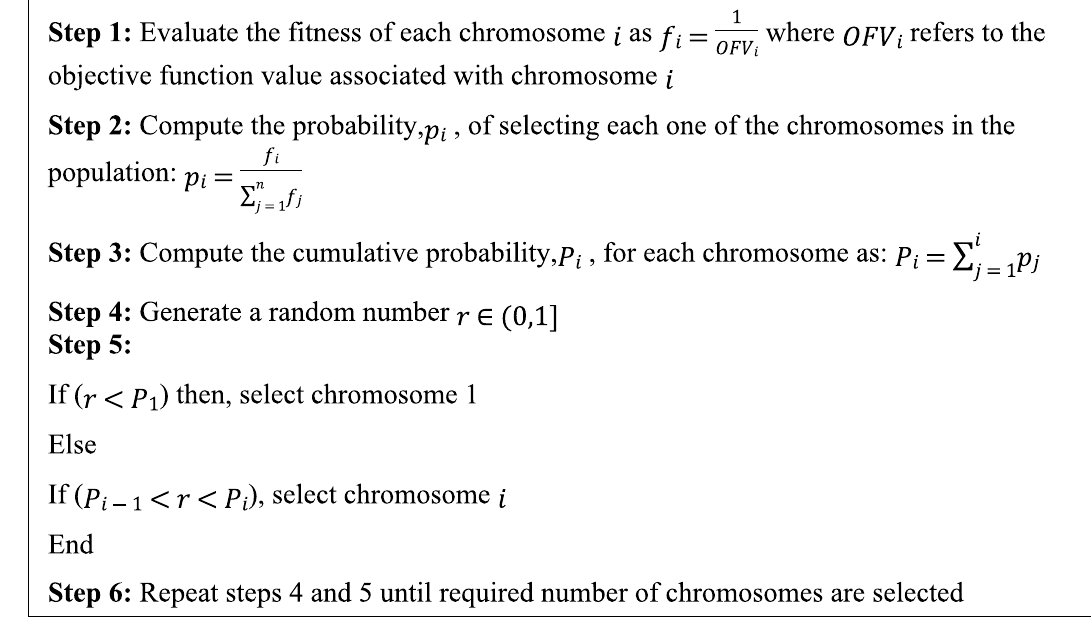
Fig. 4 Pseudocode of the biased roulette wheel